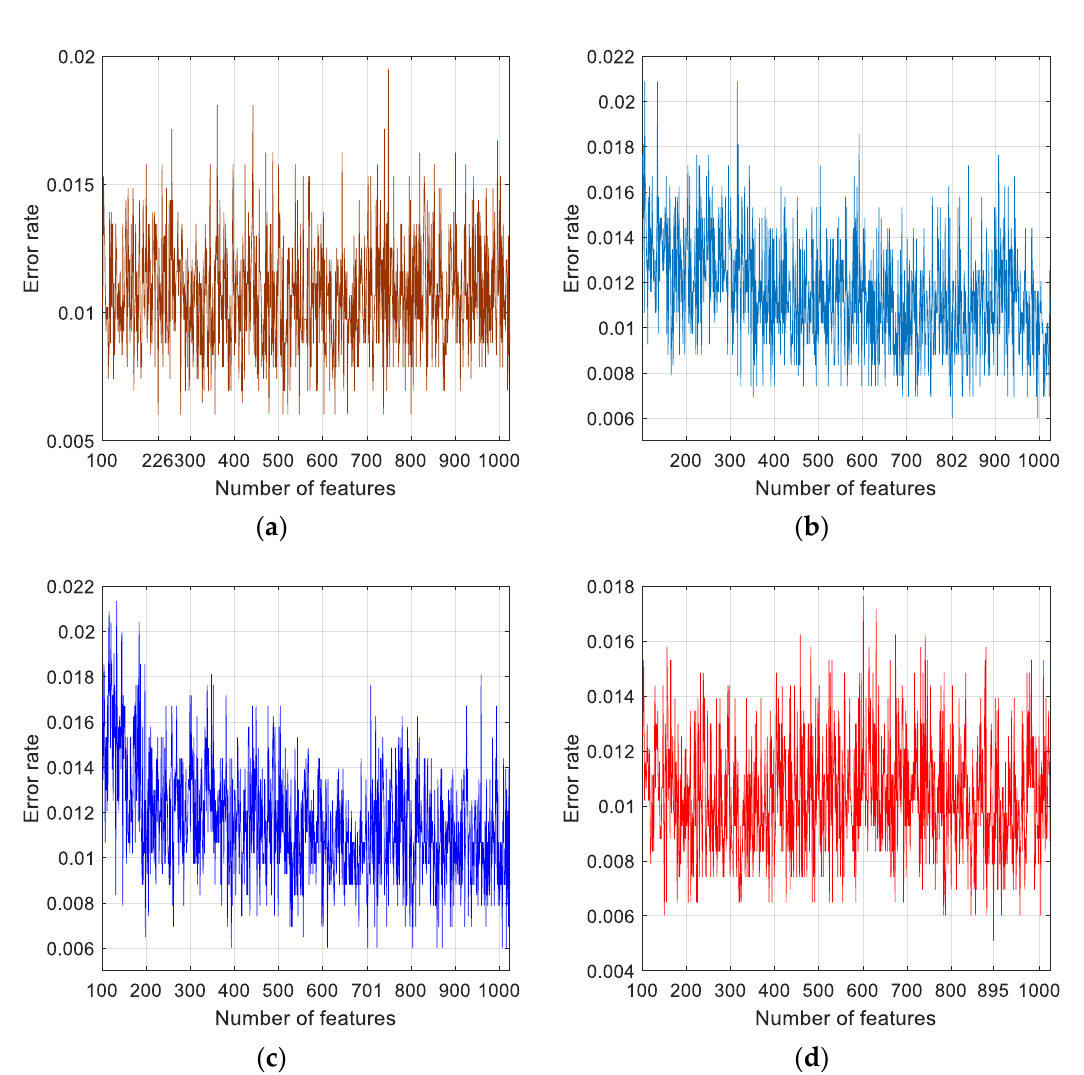
Figure 6. Plots of error rates versus number of features selected using: ( a ) iterative feature selectors IChi2, ( b ), INCA, ( c ), IRF, and ( d ) ImRMR implemented for Case 3.